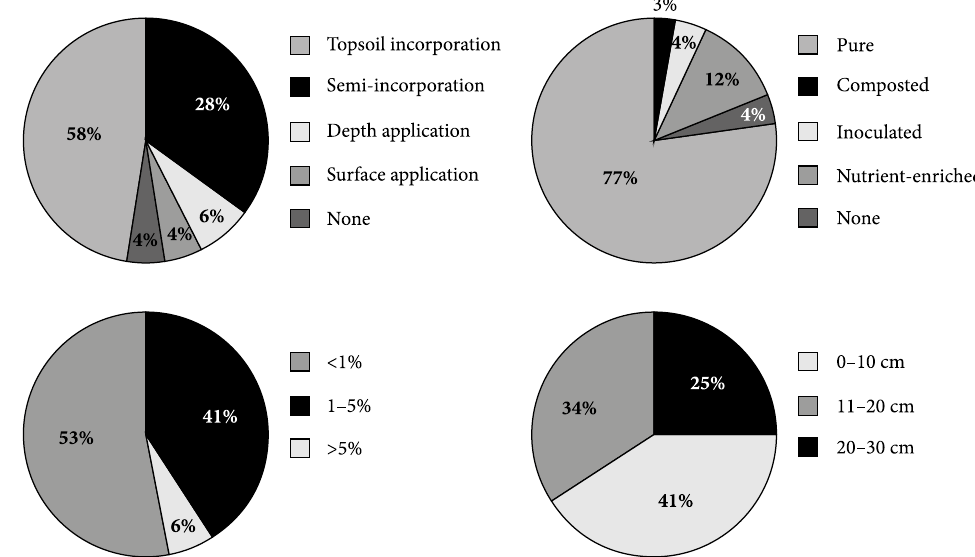
Fig. 3. Overview of biochar application strategies in Europe (Feb. 2015): application strategy (top left, n = 66); biochar treatment (top right, n = 66); biochar concentration in soil (bottom left; n = 17); application depth (bottom right, n = 66)